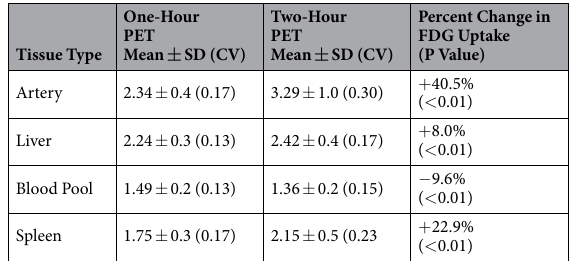
Table 2. Standardized Uptake Values at One and Two-Hour Imaging Time Points. Values are presented as mean standardized uptake values ± standard deviation (SD). CV, Coefficient of variation. Percent change was calculated as the percent increase or decrease of FDG uptake measured by SUV Max in artery and SUV Mean in background tissues from one-hour to two-hour